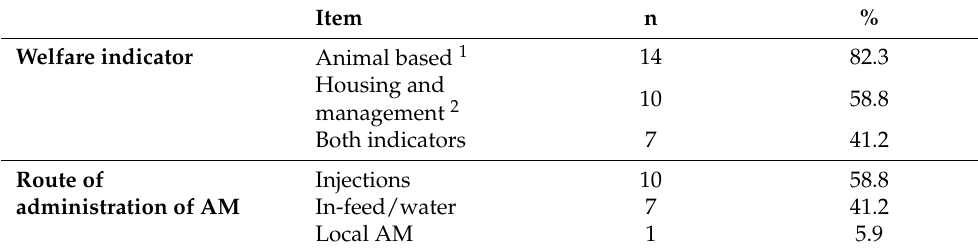
Table 6. Number and percentage of publications according to the type of welfare indicator assessed during the study and the route of administration of antimicrobials (AM). Publications can have more than one route of administration and welfare indicator